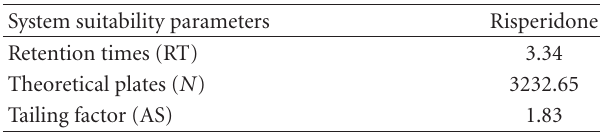
Table 3: System suitability